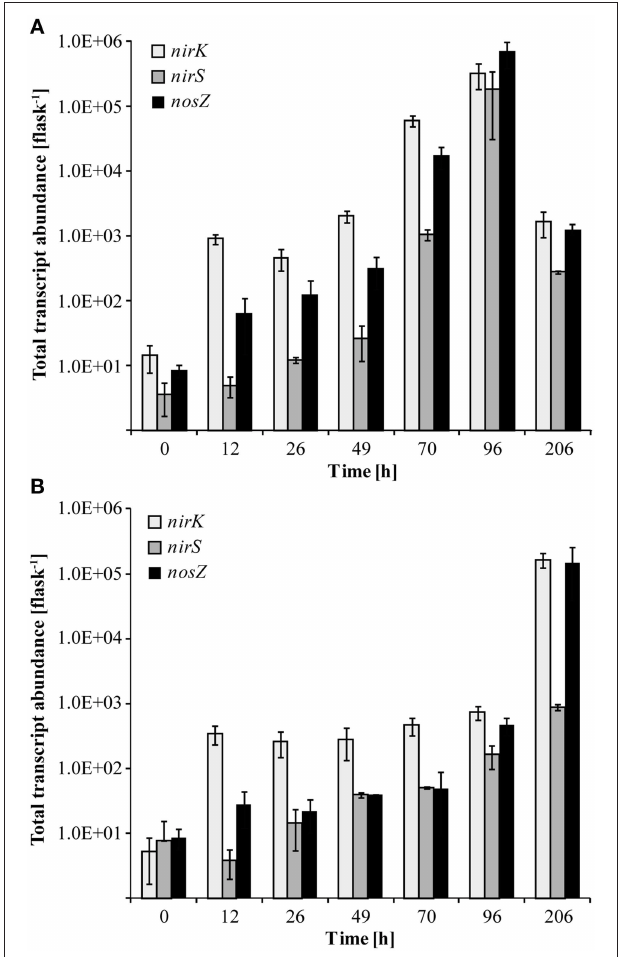
FIGURE 2 | Transcript abundance of functional marker genes for denitrification ( nirK , nirS , and nosZ ) quantified by qPCR. (A) Transcript copy numbers of the incubation at pH 7.1; (B) Transcript copy numbers of the incubation at pH 5.4 (Mean ± SD, n = 3 ).